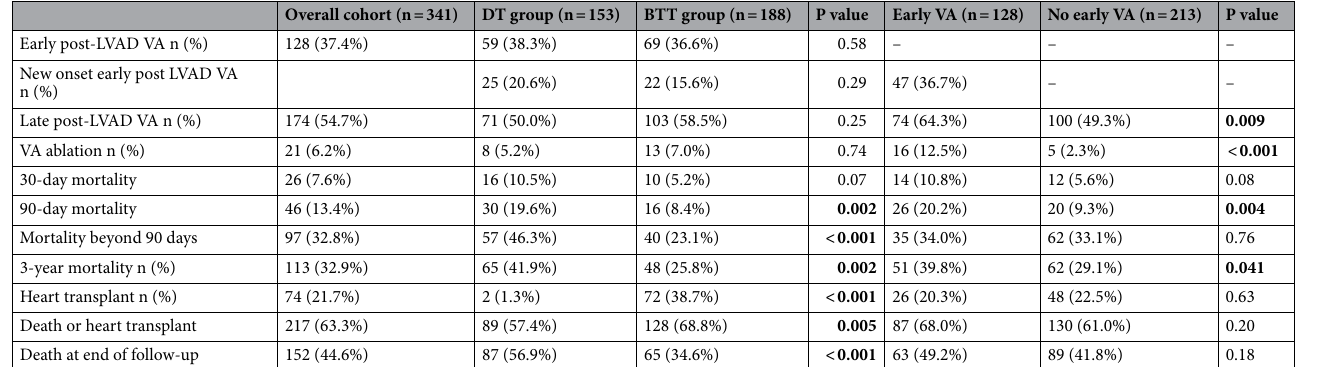
Table 2. Post-LVAD outcomes. P values presented in bold are statistically significant (<0.05). BTT bridge to transplant, DT destination therapy, LVAD left ventricular assist device, RV right ventricle, VA ventricular